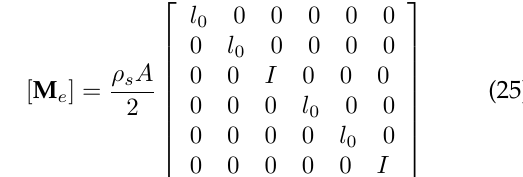
Fig. 3. Initial and current configuration of a beam element. The element initial length is l 0 and the current length in the co-rotational frame l is calculated by Eq. (15). β 0 is the element initial angle and β its current angle in the co-rotational frame (Eq. (16)). θ 1 and θ 2 are the nodes global rotations, ¯ θ 1 and ¯ θ 2 are their counterparts in the local frame (Eq.